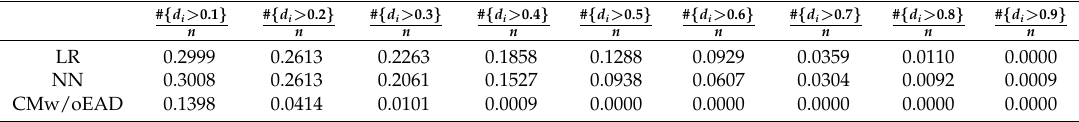
Table 8. Out-of-sample results for the difference between the estimated and observed